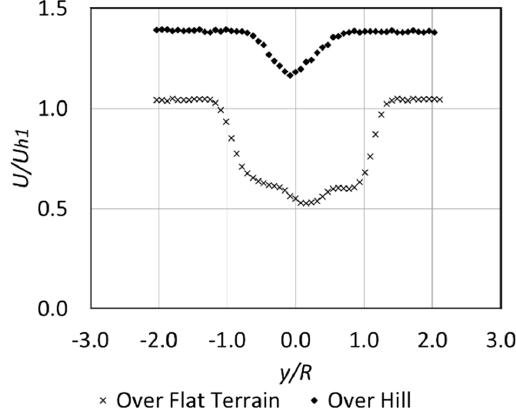
Figure 11. Comparison between configurations B and C at 3.05 D (wind turbine at x = − L , measurement at x = 0 ).